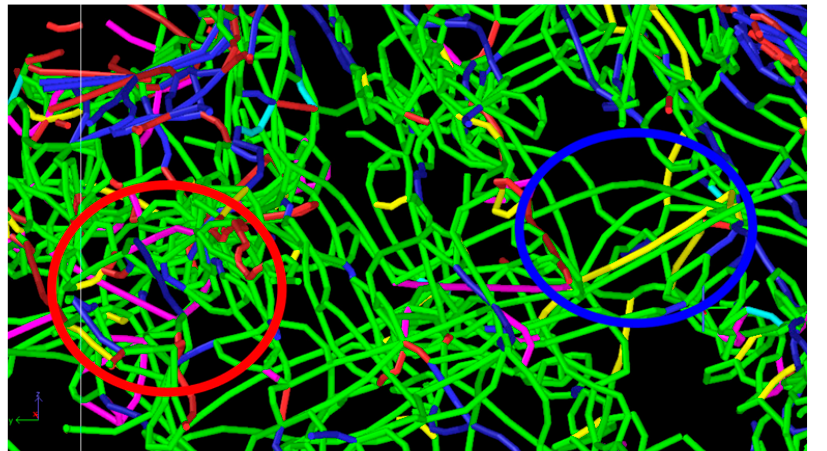
Figure 7. Inside view of the dislocation extraction algorithm for equimolar Cu-Ni alloy at 100 ps. The red circles show an area with high density of partial Shockley dislocation and the blue circle shows an area with low density of partial Shockley dislocation.